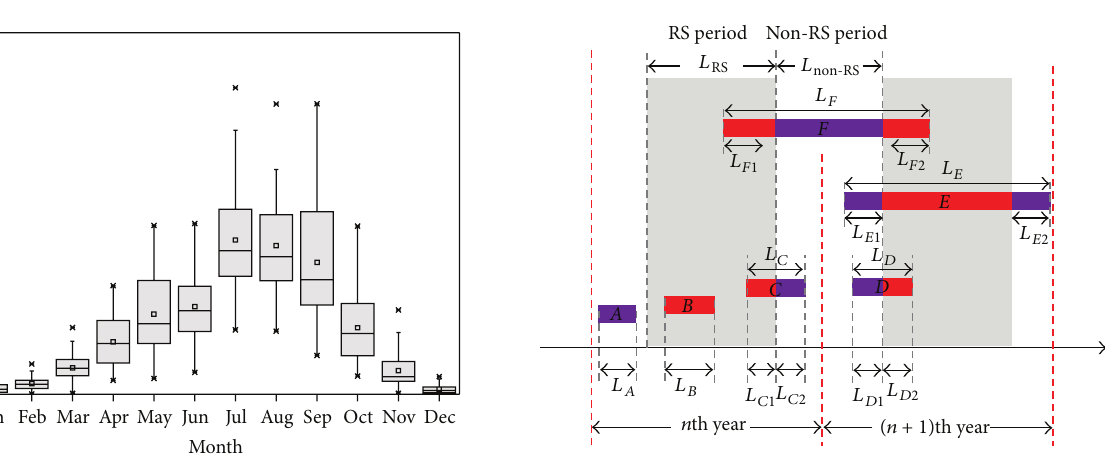
Figure 2: The boxplots of long term mean monthly precipitation of the WRB during 1960–2014.